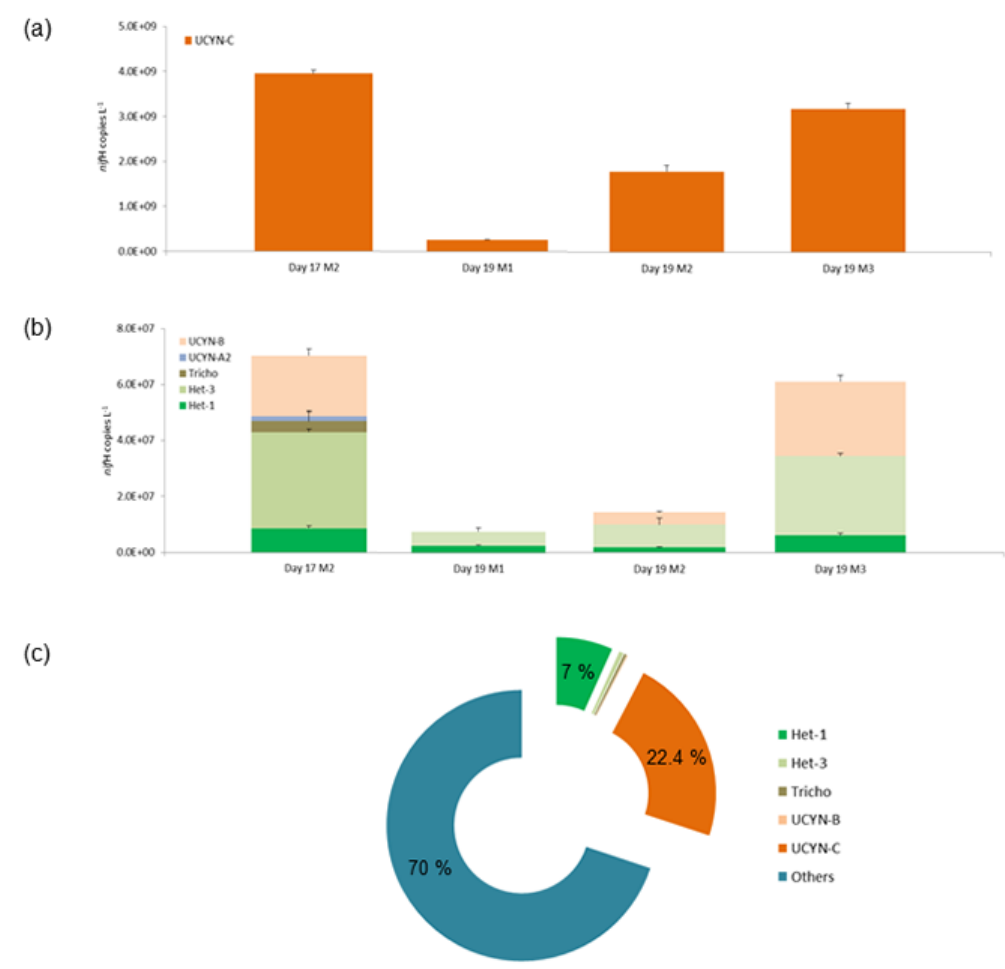
Figure 4. (a) Abundance of UCYN-C ( nif HcopiesL − 1 ) and (b) other nif H phylotypes (UCYN-A2, UCYN-B, Trichodesmium , het-1, het-3) ( nif HcopiesL − 1 ) recovered in the sediment trap on day 17 and 19. (c) Proportion of POC export associated with diazotrophs in the sediment traps on day 17 in M2 (height of UCYN-C